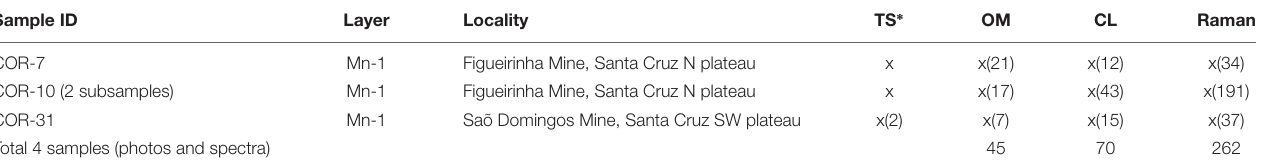
TABLE 1 | Samples and methods used.